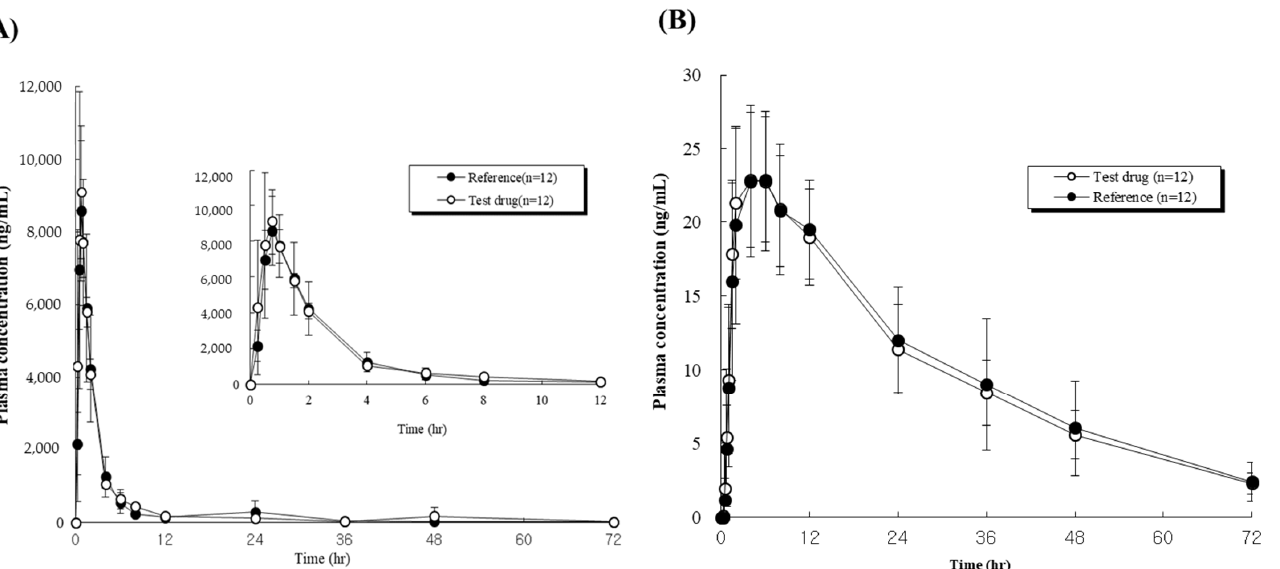
Figure 5. Design space of the wet granulations ( A ) and tablet compression process ( B ).